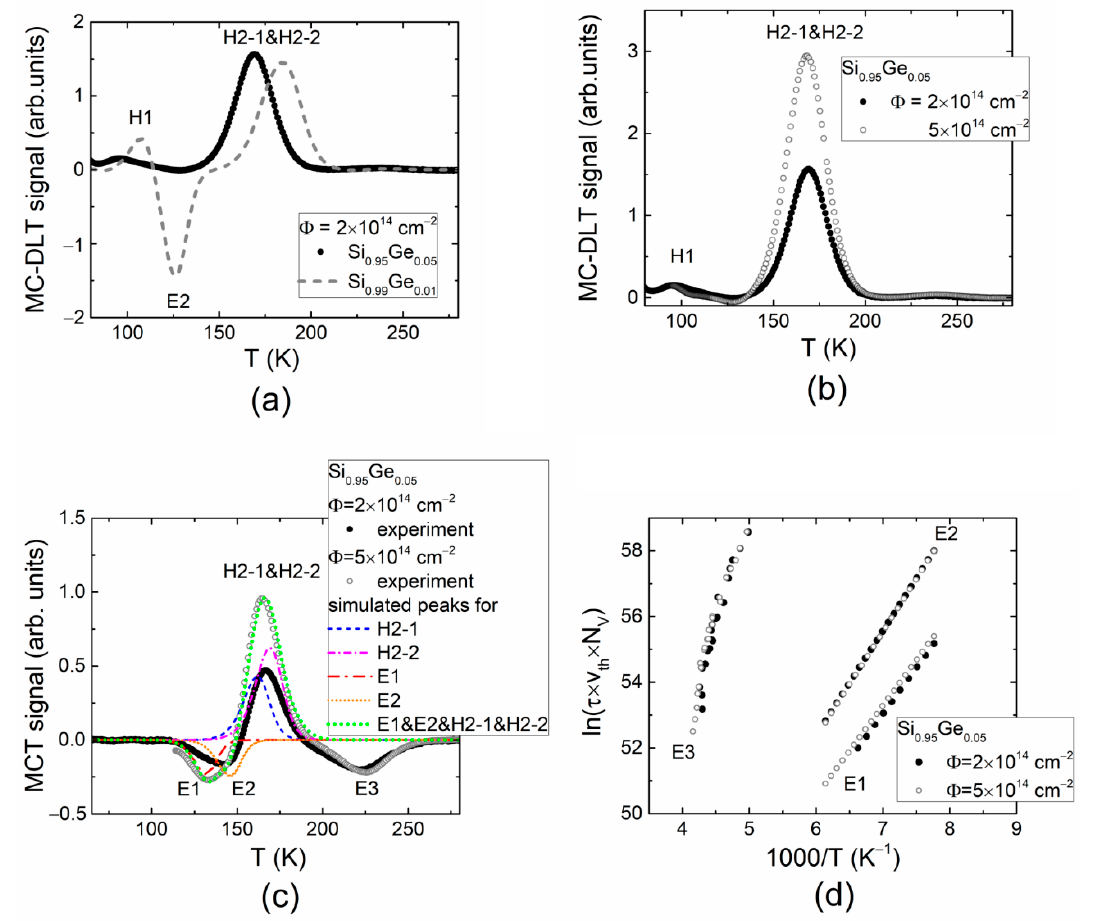
Figure 2. ( a ) Comparison of the MC-DLT spectra recorded by electrical injection of the excess carriers in the 2 × 10 14 cm − 2 fluence electron-irradiated Si 0.99 Ge 0.01 and Si 0.95 Ge 0.05 diodes; ( b ) Comparison of MC-DLT spectra recorded in Si 0.95 Ge 0.05 diodes irradiated with 2 × 10 14 cm − 2 and 5 × 10 14 cm − 2 fluence where only majority carrier trap associated peaks are observed; ( c ) Comparison of the MCT spectra recorded in Si 0.95 Ge 0.05 diodes irradiated with 2 × 10 14 cm − 2 and 5 × 10 14 cm − 2 5.5 MeV electron fluence using optical injection of the excess carrier pairs. Here, the dotted curves illustrate the simulated spectral peaks ascribed to different traps. ( d ) Arrhenius graphs plotted for different peaks in MC-DLT and MCT spectra.